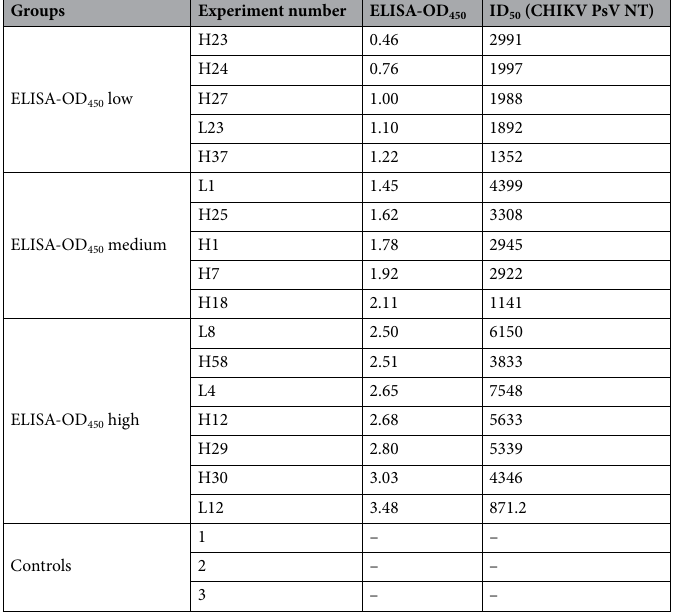
Table 1. Summary of CHIKV convalescent human sera (related to Fig. 5b). A total of 20 human serum samples (17 positive samples from CHIKV convalescent individuals, 3 negative samples from healthy individuals were used as controls), were divided into three groups according to ELISA-OD 450